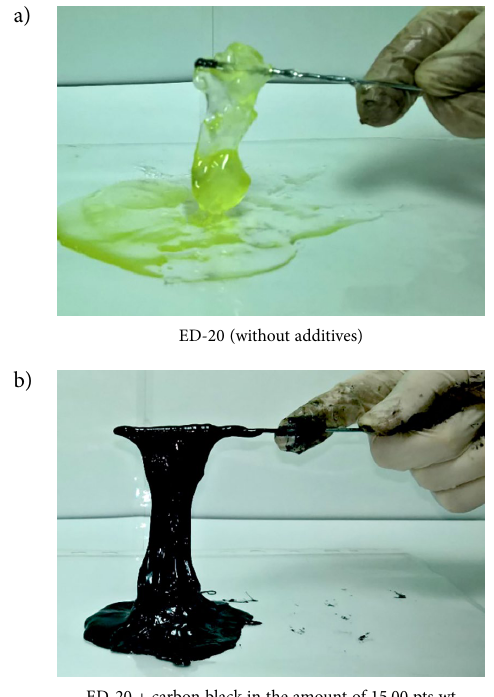
ED-20 + carbon black in the amount of 15.00 pts Figure 4. Images of epoxy oligomer ED-20 with PEPA hardener (a) and epoxy oligomer ED-20 with PEPA hardener and carbon nanosoot (b); viscosity of the consistencies analysed ≥47.65 Pa ⋅ s and 190.2 Pa ⋅ s,